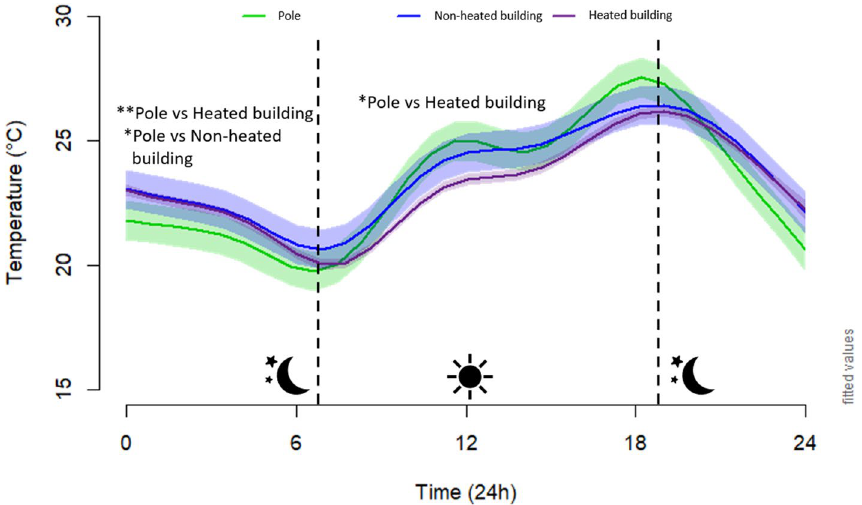
Figure 1. Estimated hourly patterns for the different Classic bat box mountings in Quebec, in 2017 (pole: n = 6, non-heated building: n = 6, and heated building: n = 6). The estimated values are based on a generalized additive mixed model, accounting for time, date, orientation, external temperature, site, and individual bat box identity. Values of fixed factors have been set to: date = July 6, orientation = east, external temperature = 18 °C. The asterisks (*) represent significant differences between structures during the day and night. P = pole and B =